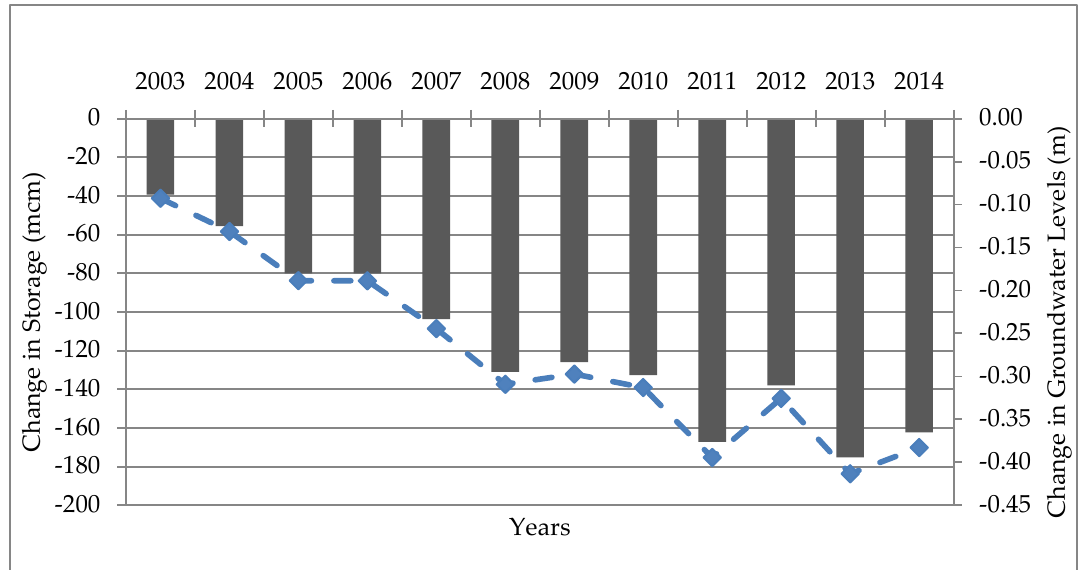
Figure 7. Change in groundwater storage and levels during 2003–2014.